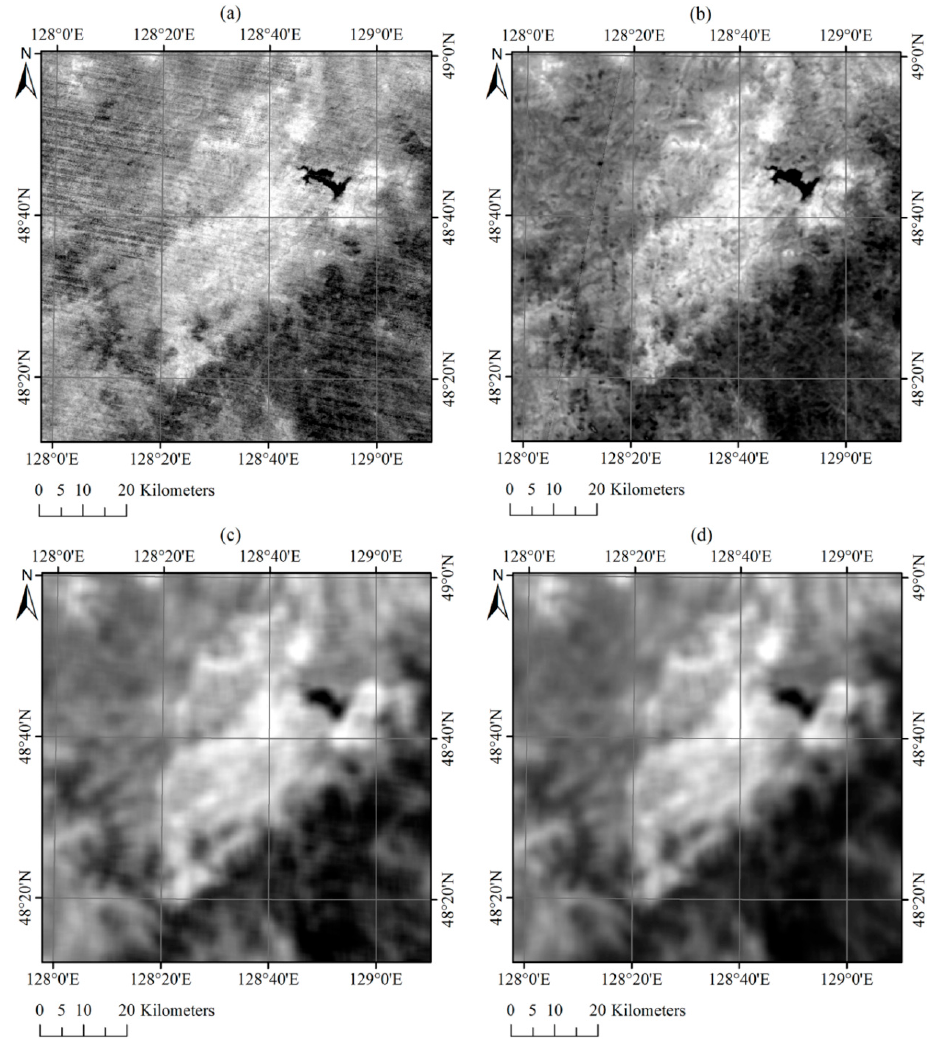
Figure 11. BT images of band 7 ( a ) and band 8 ( b ) predicted using the spatio-temporal model (STM); and BT images of band 7 ( c ) and band 8 ( d ) predicted by averaging the neighboring pixels.